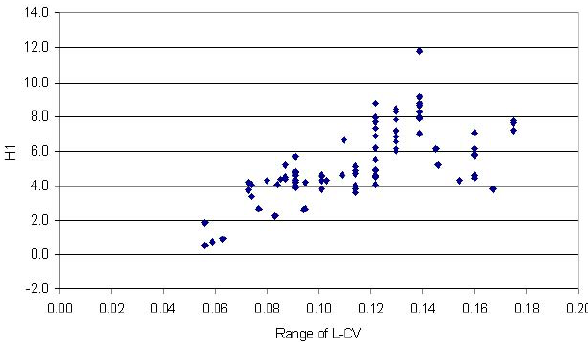
Fig. 6. H1 plotted versus m . Each point represents a pooling